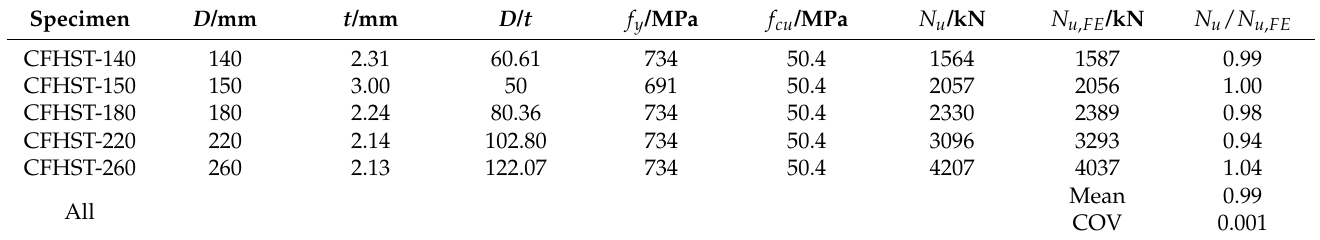
Figure 10. The comparison between the results of FEMs and tested specimens. Table 4. Comparison between test results and FE